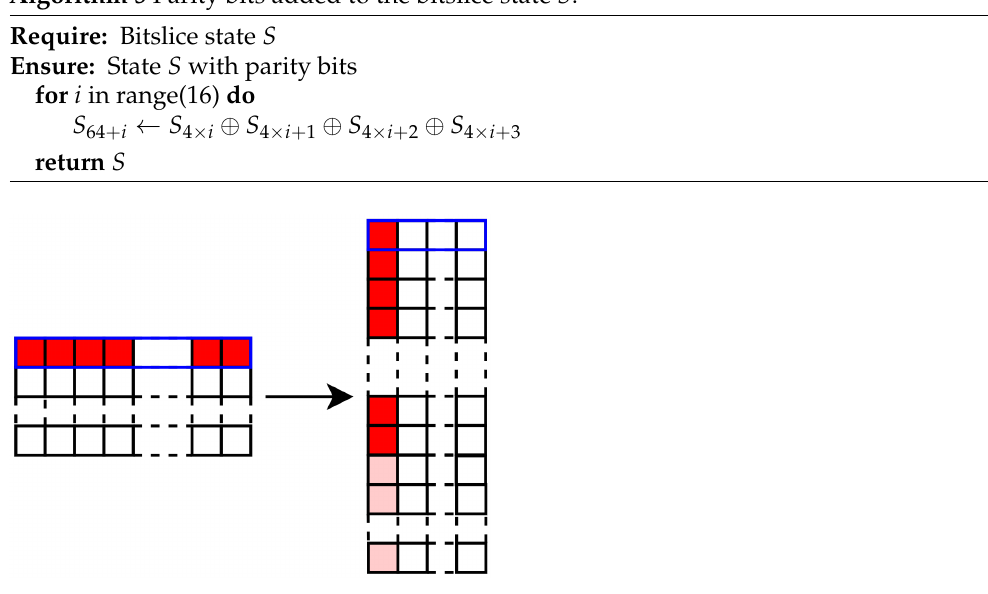
Figure 5. State after Bitslice and Parity transformations.